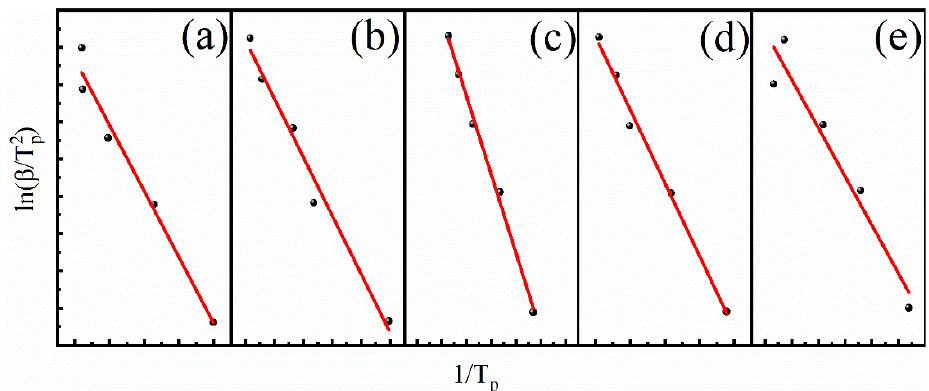
Figure 6. Relationship between ln ( β /Tp) and 1/Tp in thermal degradation. ( a ) EP-(P-M 0%), ( b ) EP-